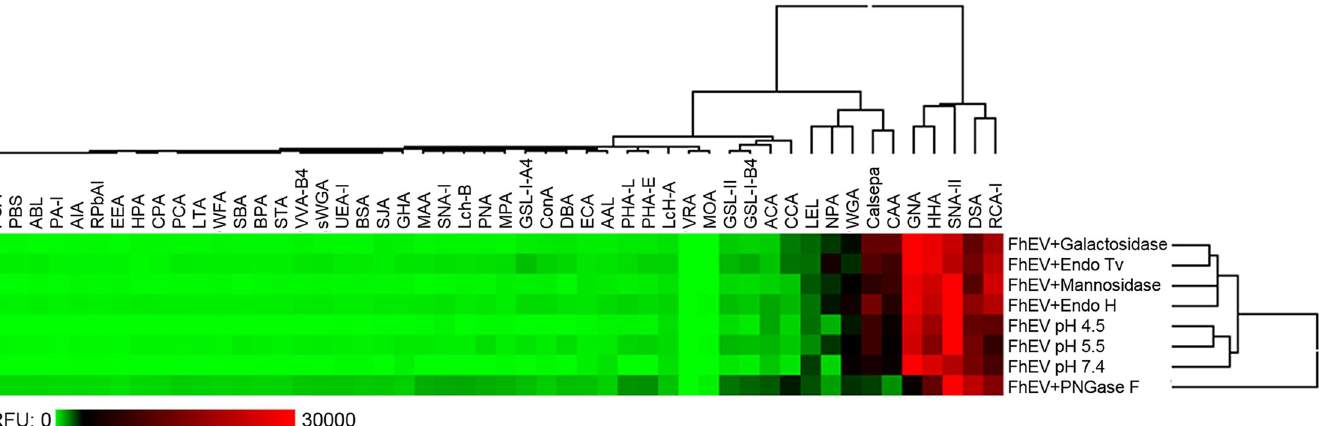
Fig 6. Comparison of the effects of glycosidase treatment on 120k EV lectin-binding profiles. Heat map of 120k EV mean lectin microarray profiles imparted by treatment with exo -glycosidases, endo -glycosidases or glyco-amidase in comparison with their respective untreated, pH-adjusted controls. Mean data derived from total intensity mean adjusted replicate data (mannosidase, galactosidase (n = 5); PNGase F, Endo Tv, Endo H (n = 4); non-enzyme controls adjusted to pH 4.5, pH 5.5, pH 7.4 (n = 3)). All data subjected to two-dimensional hierarchical clustering by average linkage, Euclidean distance method.